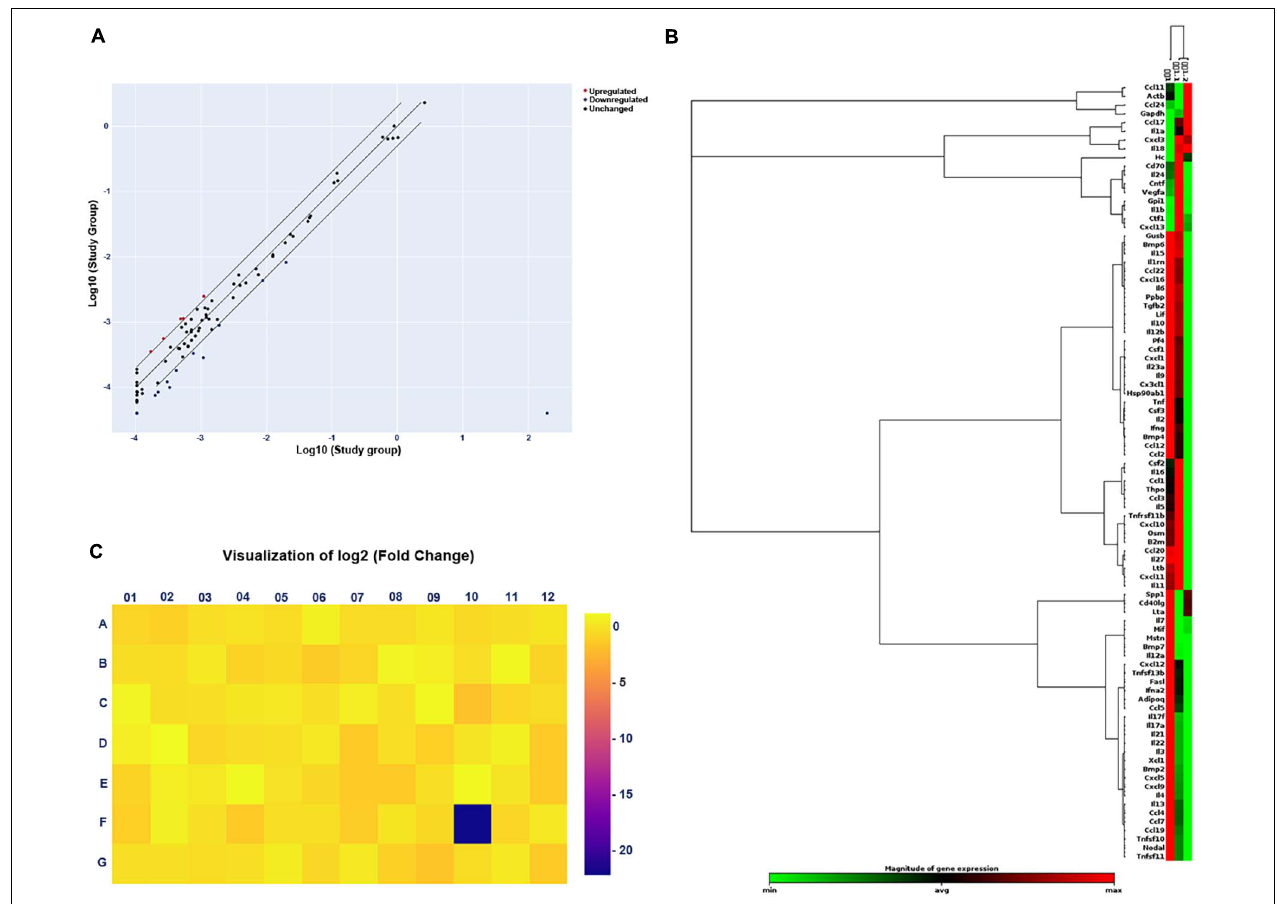
FIGURE 3 | Changes in gene expression in the study ( E. coli ) group compared with that in the control group by PCR Array. (A) Scatter plot of the results of every gene expression. The central diagonal line indicates unchanged gene expression, while the outer diagonal lines indicate the selected fold regulation threshold. Red dots denote genes with upregulated expression, while blue dots represent genes with downregulated expression. Black dots denote genes with unchanged expression. (B) Clustergram of genes with significantly upregulated or downregulated expression. Each column expresses a group, and each row represents a gene. Various colors display the magnitude of gene expression and the degree of gene expression from minimum to maximum is exhibited from green to red. (C) Heat map of the results of every gene expression. Different colors show the different levels of gene expression. Colors ranging from blue to yellow means downregulated to upregulated gene